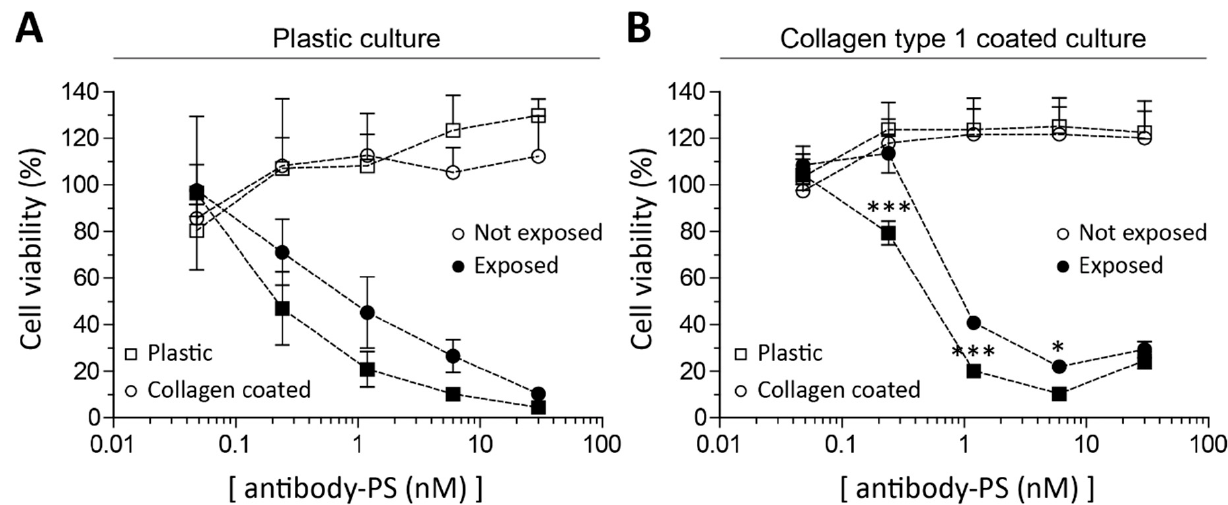
Figure 3. Application of FAP-tPDT in monolayer culture of primary lesional SSc skin fibroblasts cultured on different substrates. Primary skin fibroblasts were isolated and cultured on either plastic ( A ) or collagen type 1 ( B ) and subsequently seeded on plastic or collagen type 1 to determine the dose response of PS-FAP antibody construct in these conditions after exposure to light. For plastic cultured cells the LD 50 of the tPDT construct was 0.25 nM and 1 nM for cells seeded on plastic and collagen respectively. For collagen cultured cells, the LD 50 of the tPDT construct was 0.5 nM and 1 nM respectively. ( n = 4 replicates per donor). *= p <0.05, ***= p <0.001.